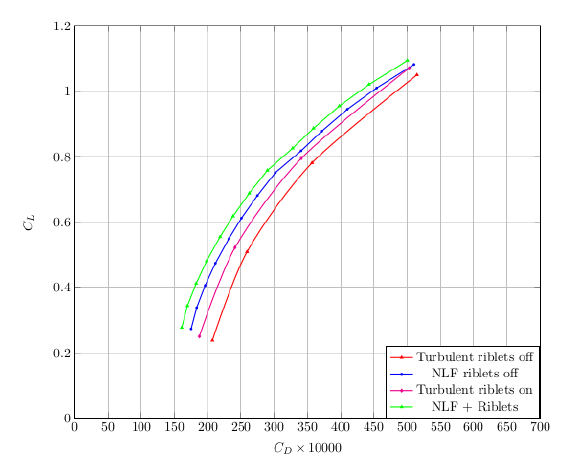
Figure 13. NLF wing body configuration: M ∞ = 0.64, Re ∞ = 18.2 × 10 6 . Lift drag polar curves with and without riblets [35].